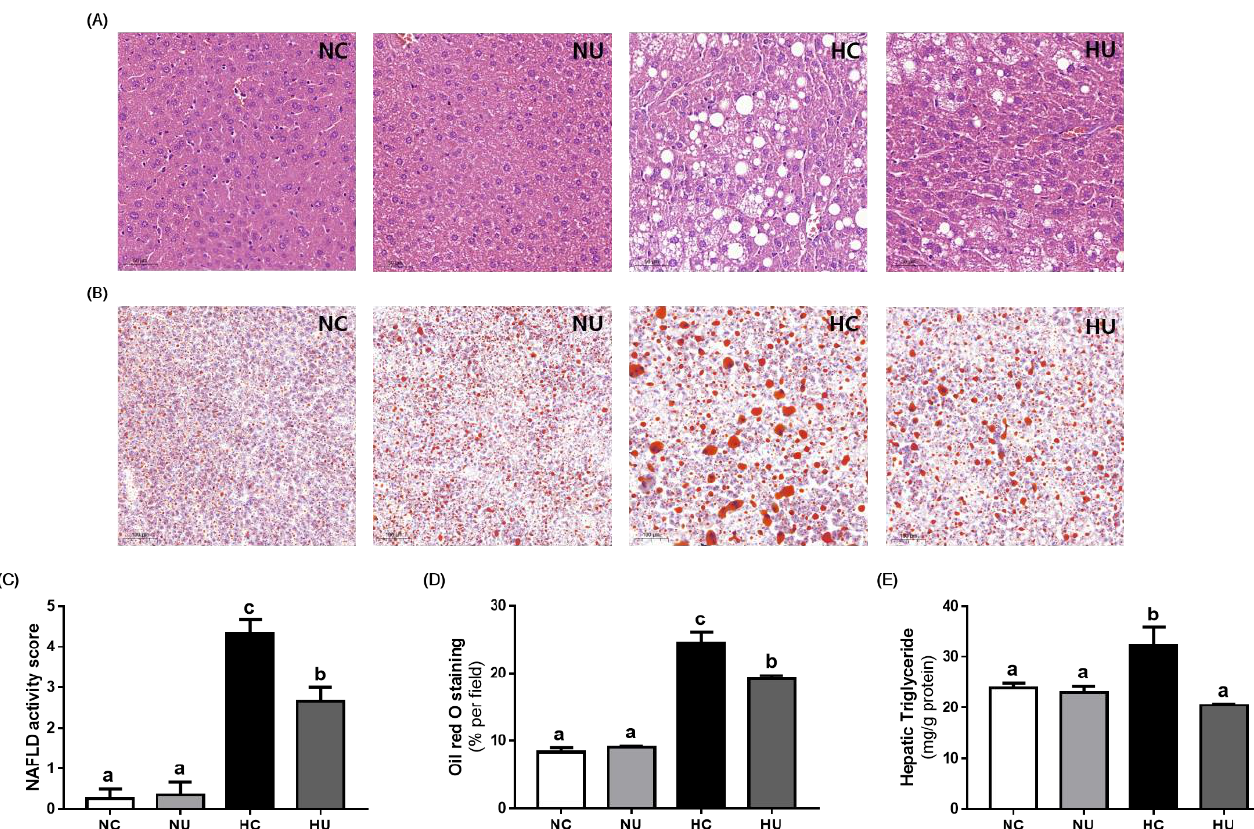
Figure 4. Effects of Bacteroides uniformis CBA7346 treatment on histological parameters of liver tissues in mice with high-fat diet-induced non-alcoholic fatty liver disease. ( A ) Representative histological results of H&E staining and ( B ) ORO staining; ( C ) quantification of NAFLD activity score and ( D ) ORO stained area; ( E ) hepatic triglyceride. NC, control group on normal diet; NU, group on normal diet receiving 1 × 10 6 CFU B. uniformis CBA7346 thrice a week; HC, control group on high-fat diet; HU, group on high-fat diet receiving 1 × 10 6 CFU B. uniformis CBA7346 thrice a week. Data are presented as mean ± SEM ( n = 3). Means with different letters (a–c) indicate significant difference ( p < 0.05) among groups. Groups were compared using Duncan’s multiple range tests.